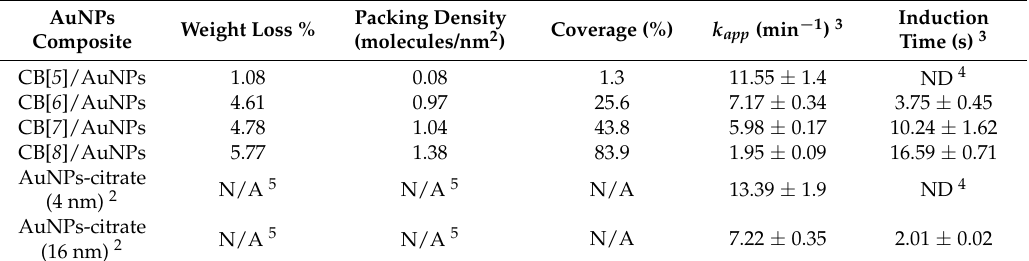
Table 2. Percent of weight lost by TGA, calculated packing density for CB[ n ]/AuNPs, and apparent kinetic constant ( K app ) and induction time of 4-NP reduction catalyzed by AuNPs 1